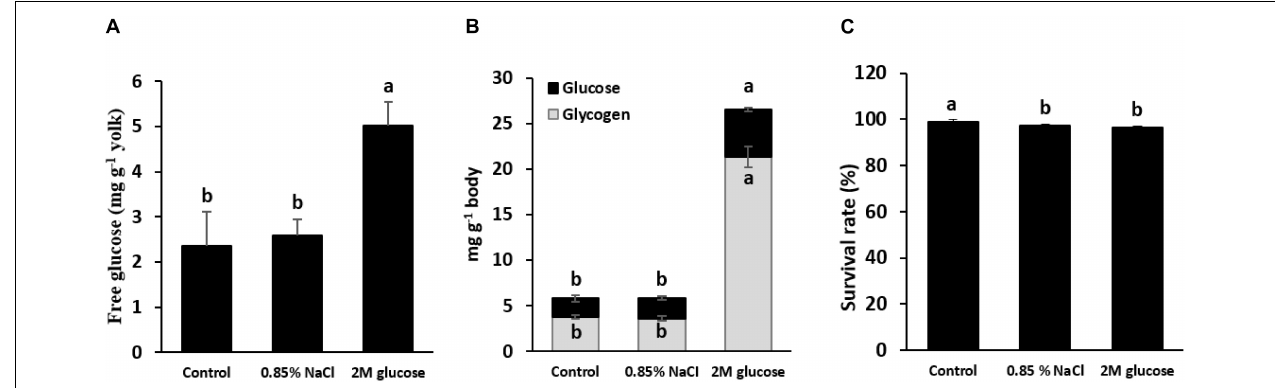
FIGURE 2 | Glucose content in the yolk reserves of alevins and their subsequent bodily glucose and glycogen content. (A) Glucose levels in the yolk of alevins that were microinjected with saline (0.85% NaCl) or glucose (2 M), as well as the control (non-injected alevin). Note that fish alevins were sampled for examination of the glucose level in the yolk sac immediately after injection. At 1 wpi, the glucose content and glycogen content were examined in the bodies of larvae injected with saline (0.85% NaCl) and glucose (2 M) and in the control (non-injected) larvae (B) , and their survival rates were determined (C) . Different letters in the bar graph indicate significant differences ( P <